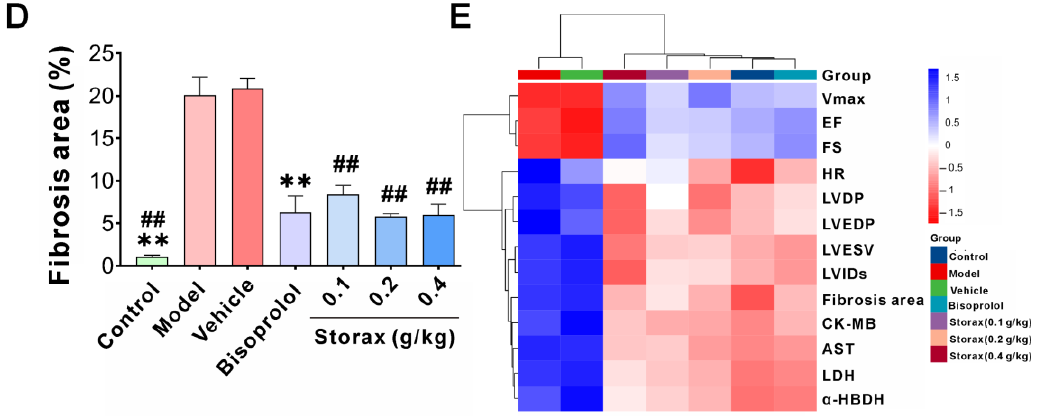
Figure 5. Effect of storax on myocardial injury and fibrosis in ISO-induced AMI rats. ( A ) Quantitative analysis of the expression levels of aspartate aminotransferase (AST), creatine kinase iso-enzyme (CK-MB), lactate dehydrogenase (LDH) and α -hydroxybutyrate dehydrogenase ( α -HBDH) in serum of rats in different groups (n = 6). ( B ) Representative images of hematoxylin–eosin (HE) staining in each group (scale bar = 250 µ m or 50 µ m, n = 4), vascular congestion (green arrows), macrophages (blue arrows), edema (red arrows), necrosis (yellow arrows). ( C ) Representative images of Masson staining in each group (scale bar = 250 µ m or 50 µ m, n = 4). ( D ) Quantitative analysis of the proportion of collagen fibers. The blue-stained area is collagen fiber organization. ( E ) Heat map of cluster analysis of biochemical indexes regulated by different groups. Results are presented as mean ± SD. One-way ANOVA followed by Bonferroni’s post hoc test: ** p < 0.01 vs. model group; # p < 0.05, ## p < 0.01 vs. vehicle group.